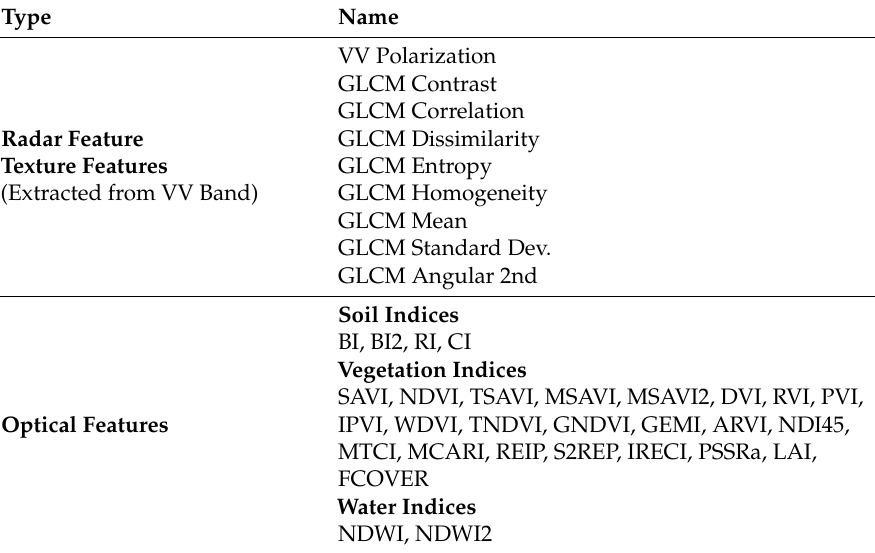
Table 2. Extracted texture and optical features from Sentinel-1 and Sentinel-2